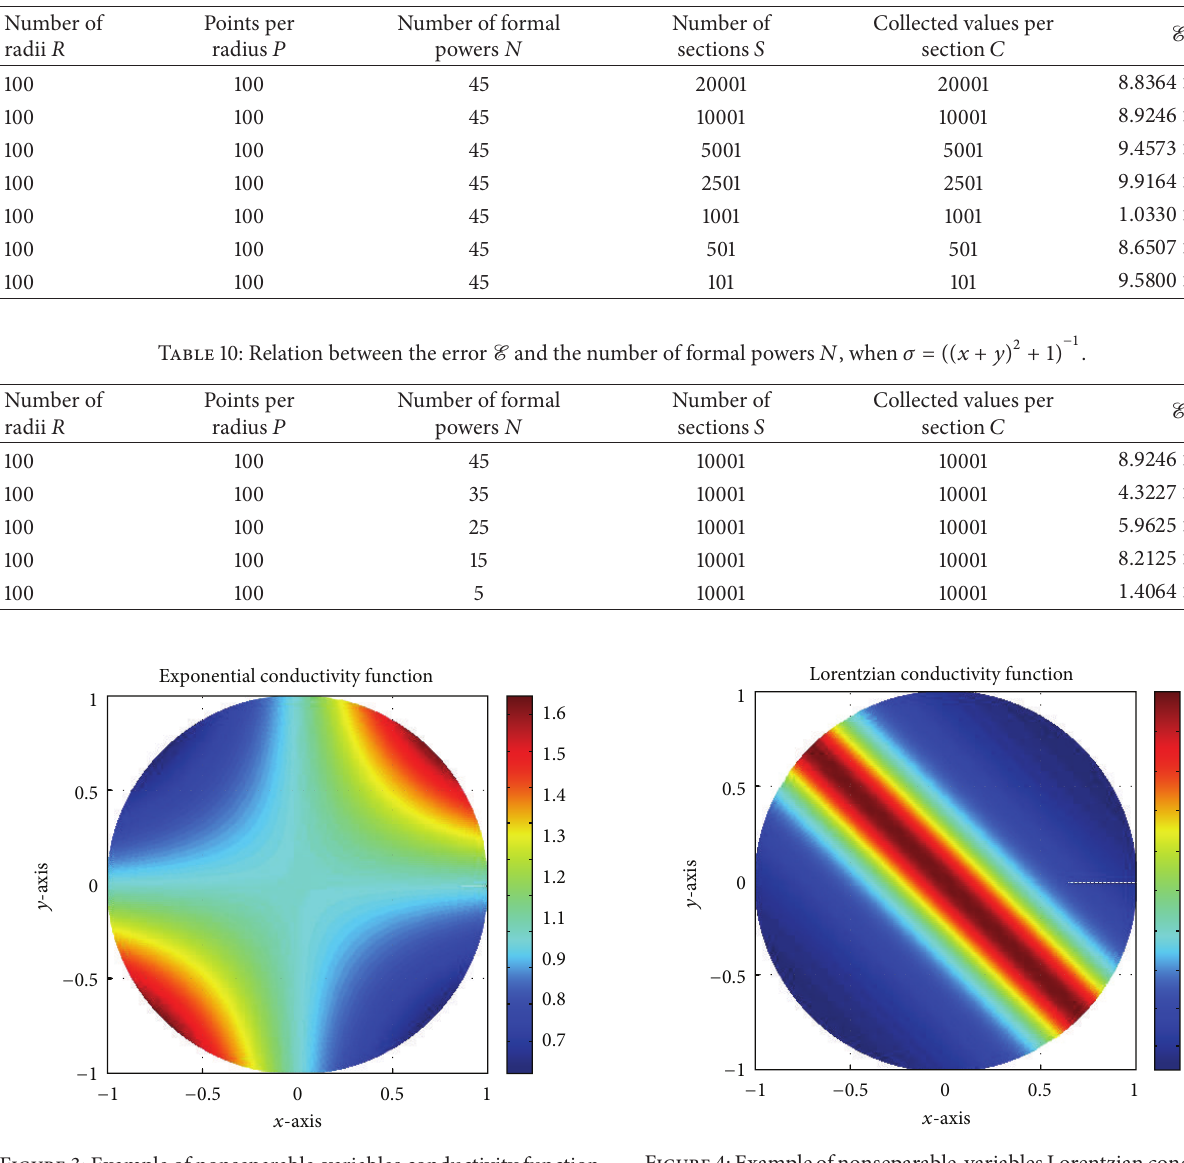
Table 9: Relation between the error E and the number of sections 𝑆 and samples per section 𝐶 , when 𝜎 = ((𝑥 + 𝑦) 2 + 1)